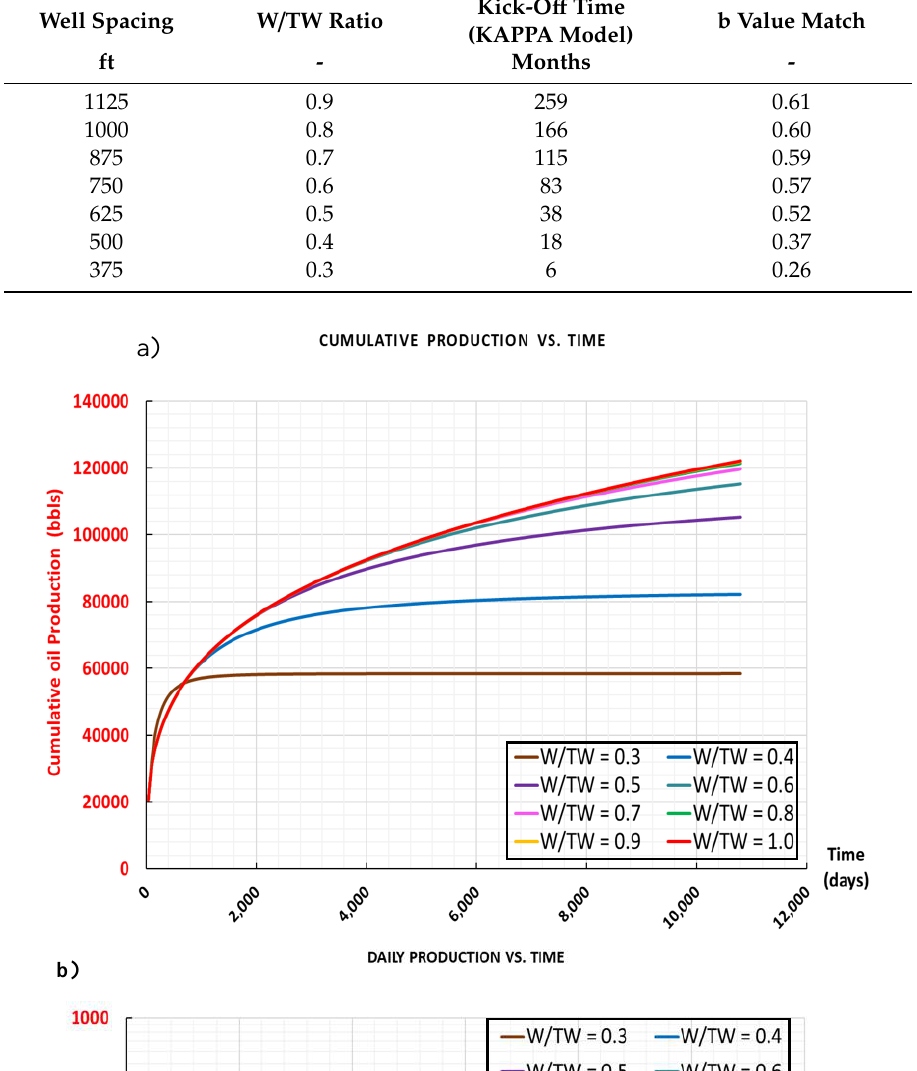
Table 4. History matched b values for given KAPPA model kick-off times with decreasing well spacing.